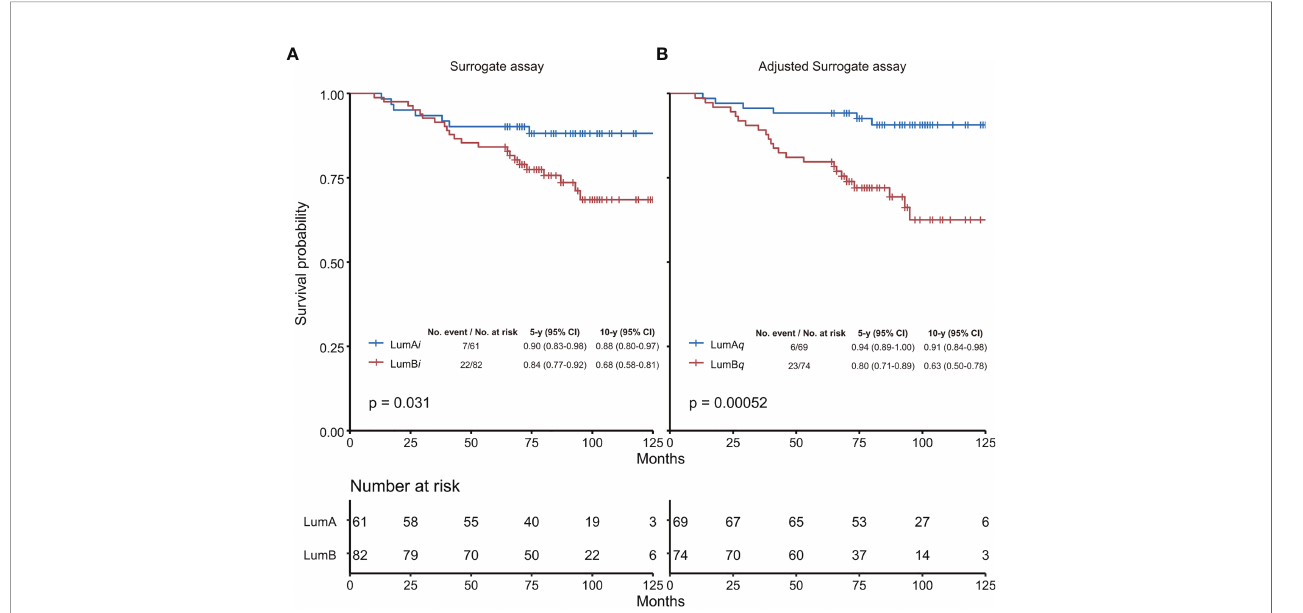
FIGURE 3 | Overall survival analysis by surrogate assay (A) or adjusted surrogate assay (B) . (A) The Ki67 score of 14% was used as cutoff in the surrogate assay based on Recommendations from 2013 St. Gallen Consensus. (B) The Ki67 level of 2.31 nmol/g was used as cutoff determined by the “ surv_cutpoint ” function of the “ surviminer ” R package in the adjusted surrogate assay. The 5-year and 10-year survival probabilities, and the p -values from Log rank test were provided for both the surrogate assay and the adjusted surrogate assay, respectively. LumA, Luminal A-like subtype; LumB, Luminal B-like subtype; LumA i and LumB i , Luminal A-like and B- like subtypes by IHC-based surrogate assay; LumA q and LumB q , Luminal A-like and B-like subtypes by QDB-based adjusted surrogate assay; CI, con fi dence